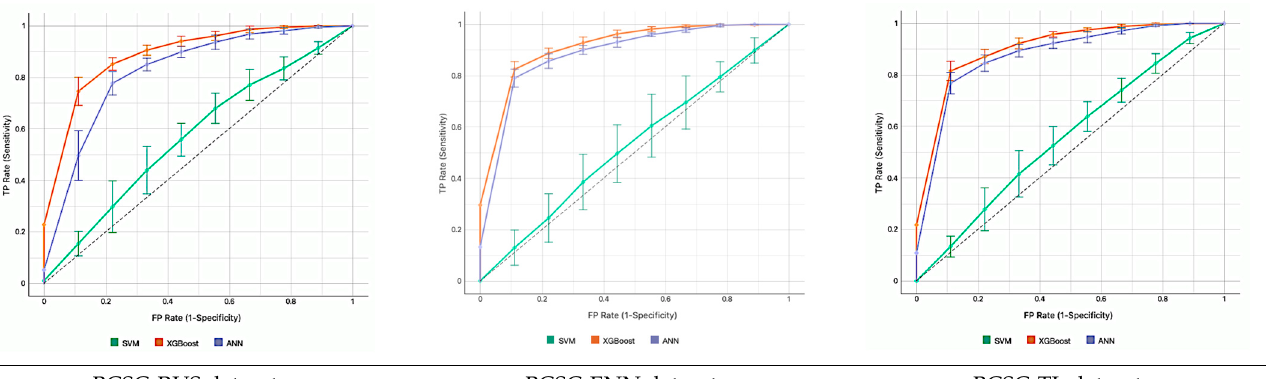
Table 14. ROC analysis of all the models based on the datasets balanced using hybrid sampling techniques.